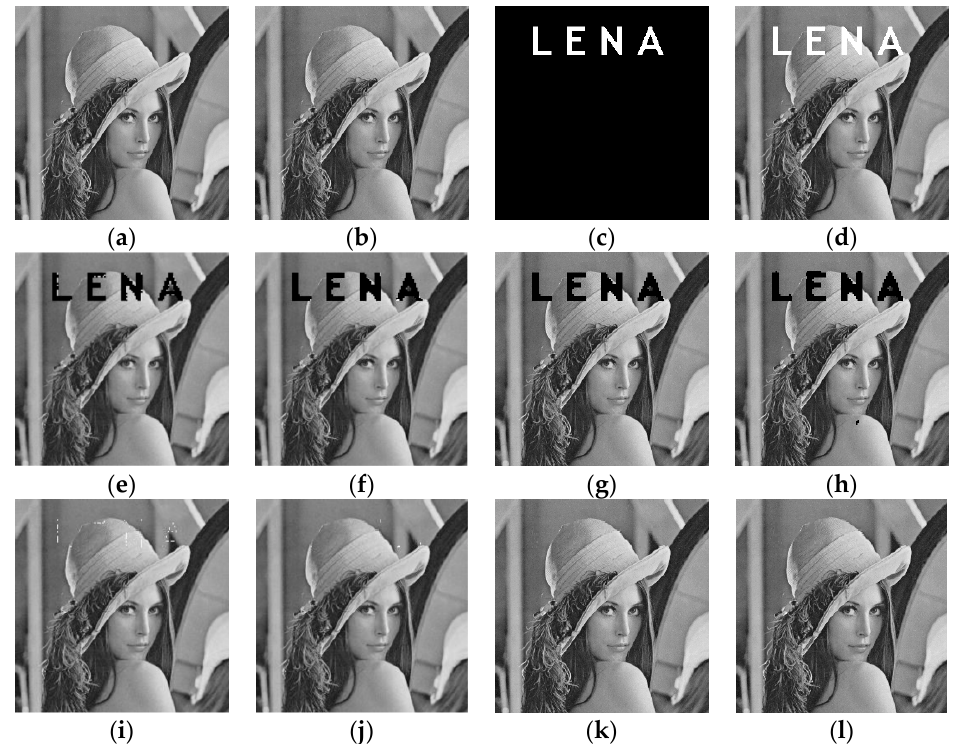
Figure 7. Tamper detection and recovery results of text addition attack on Lena image: ( a ) original image; ( b ) watermarked image; ( c ) tamper reference; ( d ) tampered image; ( e ) tamper detection result of [8]; ( f ) tamper detection result of [9]; ( g ) tamper detection result of [7]; ( h ) tamper detection result of the proposed method; ( i ) recovery result of [8]; ( j ) recovery result of [9]; ( k ) recovery result of [7]; ( l ) recovery result of the proposed method. Table 2. Comparison of recovery performance for text addition attack on Lena